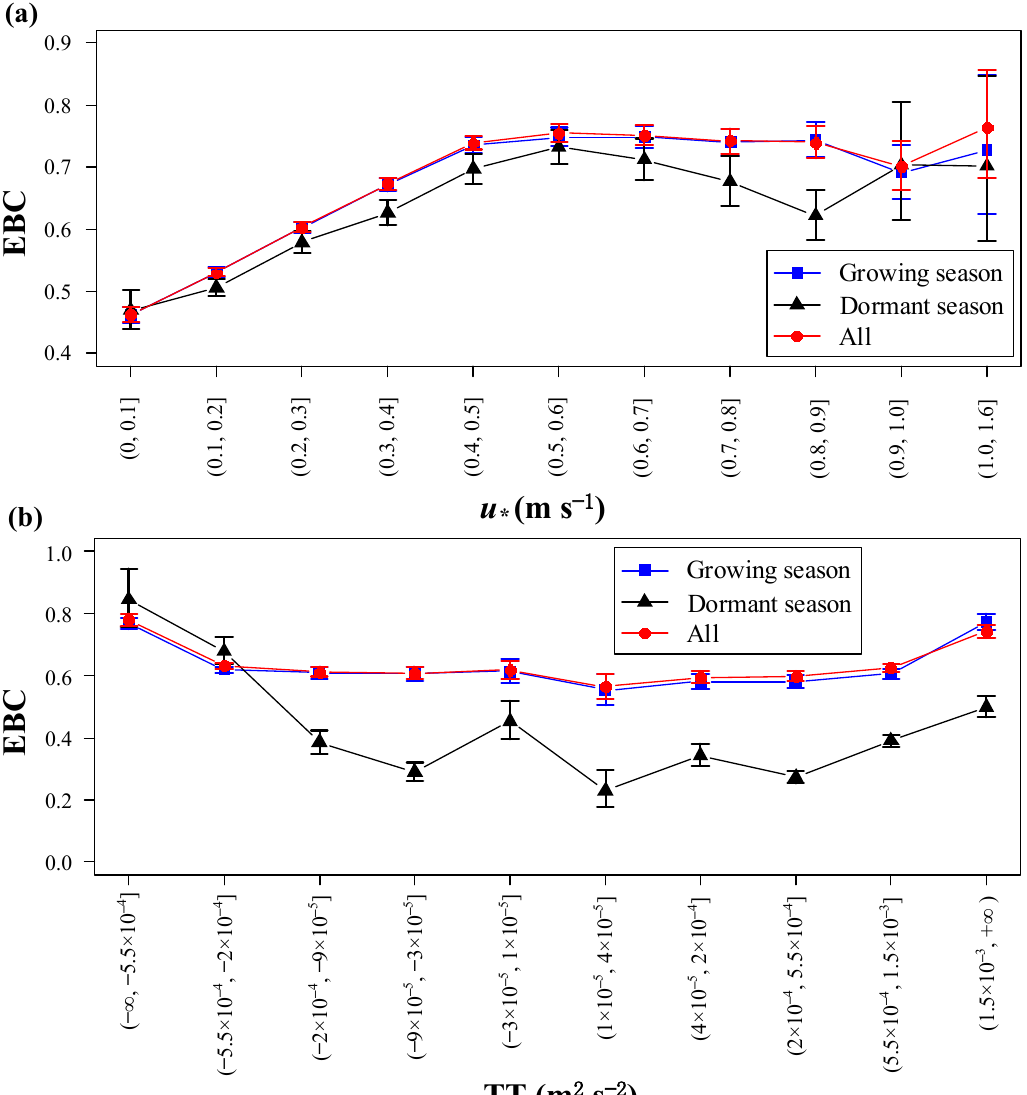
Figure 11. Average EBC for each bin of ( a ) friction velocity ( u ∗ ) and ( b ) the thermally induced turbulent parameter (TT).